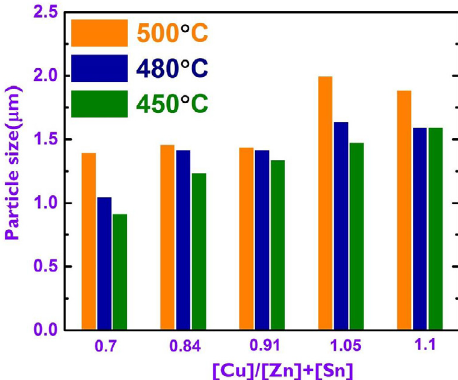
Fig. 5. Schematic showing the evolution of particle size with temperature for different [Cu]/[Zn] + [Sn] ratios. (The ferret diameter could not be measured for the CZTSe absorber with [Cu]/([Zn] + [Sn]) ratio 0.77 and hence, it is not shown